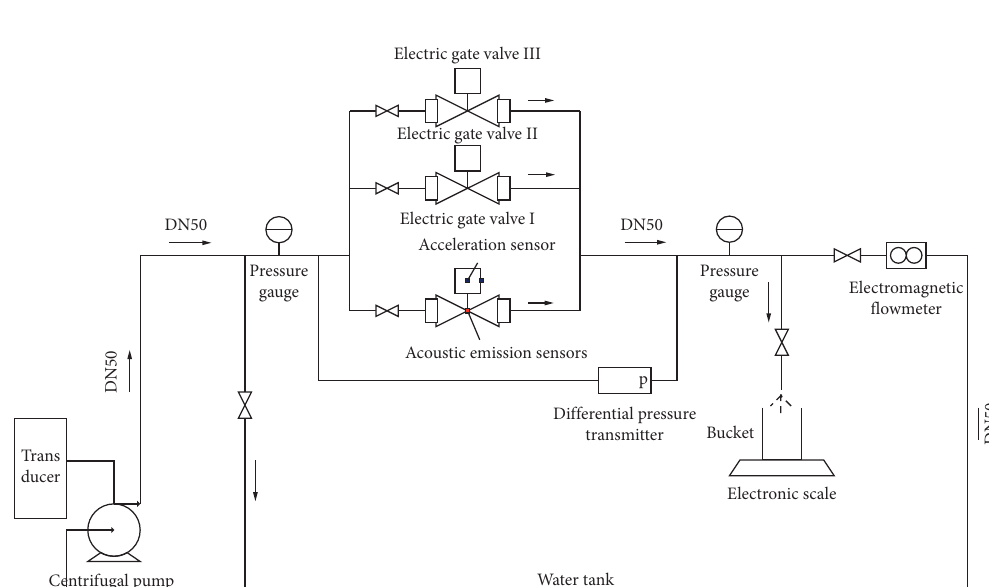
Figure 5: Overall flowchart of experiment